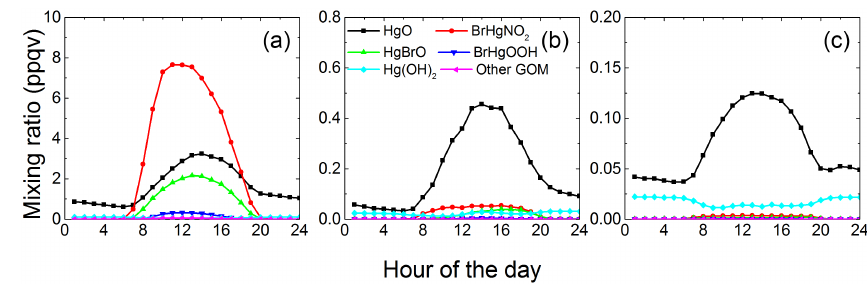
Figure 3. Simulated average diurnal cycles of GOM speciation at AI (a) , TF (b) , and PM (c) .